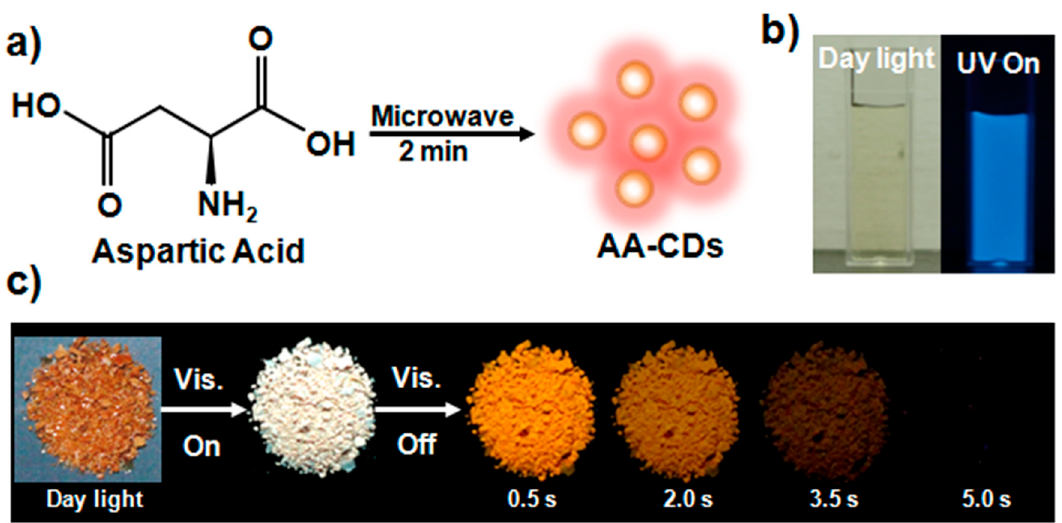
Figure 1. ( a ) Schematic illustration of the preparation process for visible-light-excited matrix-free room temperature phosphorescent (RTP)carbon dots (CDs) named AA-CDs. ( b ) Photographs of AA-CDs water dispersion under daylight and ultraviolet(UV) light (365 nm). ( c ) Photographs of the AA-CDs powder under the daylight, a visible light LED (420 nm) and delay time after ceasing the LED irradiation.